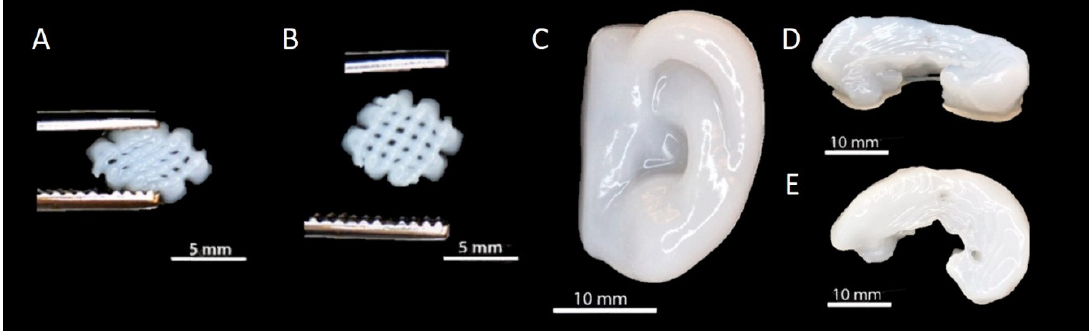
Figure 3. The 3D printed structures from nanocellulose-reinforced alginate hydrogels: ( A ) Small grid squeezed with tweezers, ( B ) grid recovery after squeezing, ( C ) human ear, ( D ) side view of a sheep meniscus and ( E ) top view of a sheep meniscus [66].